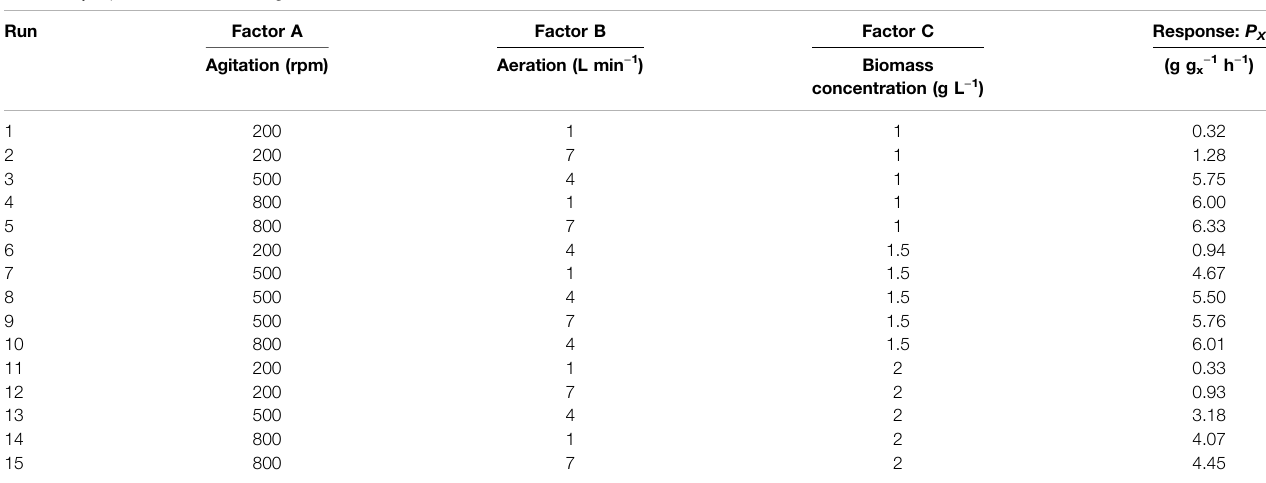
TABLE 2 | Experimental matrix